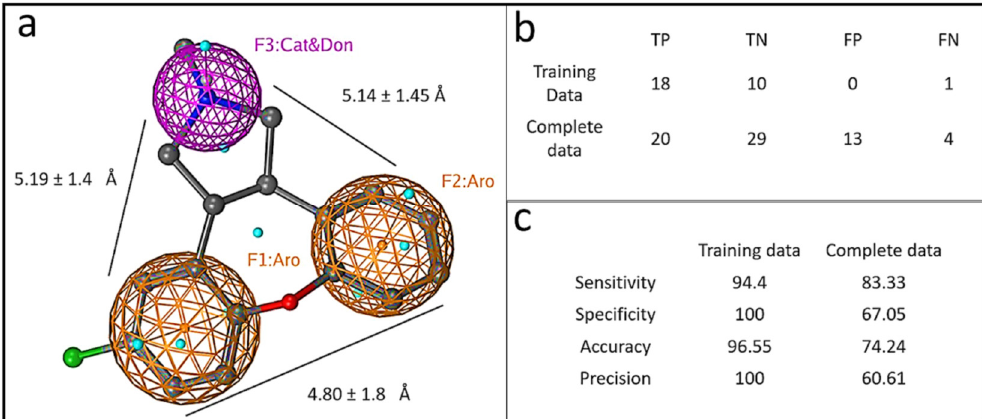
Figure 2. Graphical depiction of pharmacophore model. ( a ) A three point pharmacophore model based on the kite-shaped molecules. The asenapine structure is superimposed (ball and stick representation) for comparison. Brown mesh represents aromatic moieties (Aro) and magenta mesh represents a H-bond donor/cation group (Cat&Don). Small spheres (cyan) highlight features in asenapine that are not relevant for the overall pharmacophore. ( b ) Displays the numbers of true (T) and false (F) positive (P) and negative (N) hits within the datasets that are discriminated by the pharmacophore (see Methods). Panel ( c ) summarizes the pharmacophore model performance.